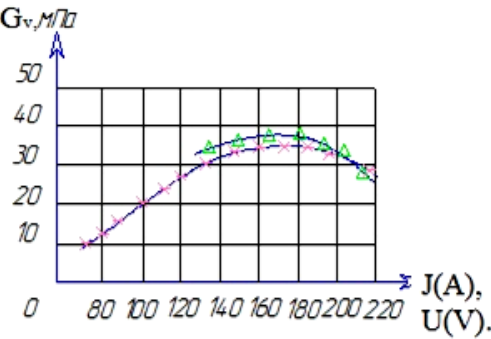
Figure 3. The dependence of the adhesion strength and the level of cracking of the coating on the spraying distance l at rotational speeds of 5 m/s (1), 1.5 m/s (2), and 0.15 m/s (3).